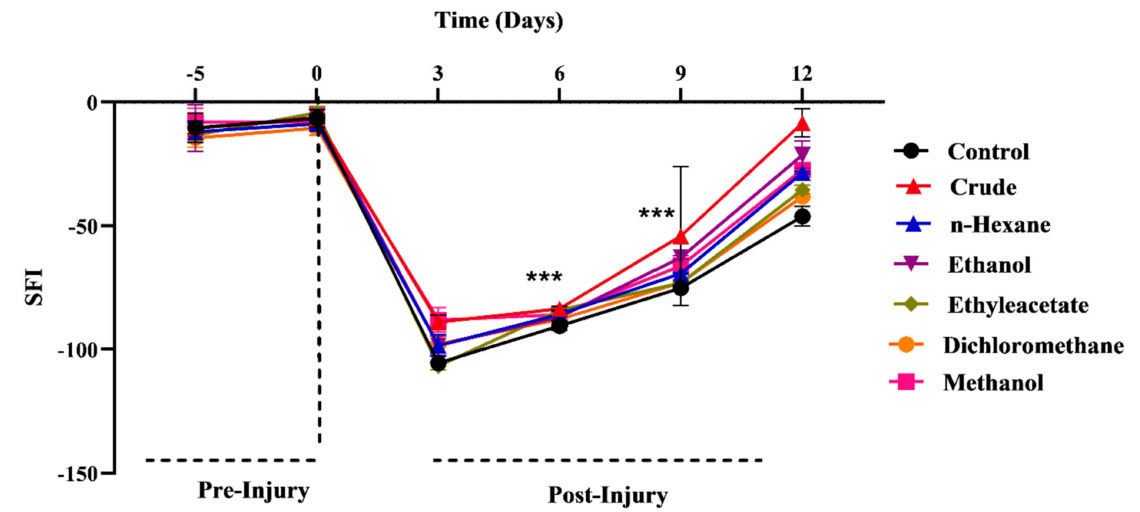
Figure 3. Influence of M. oleifera on SFI following sciatic nerve lesion. *** show the significance of results statistically.